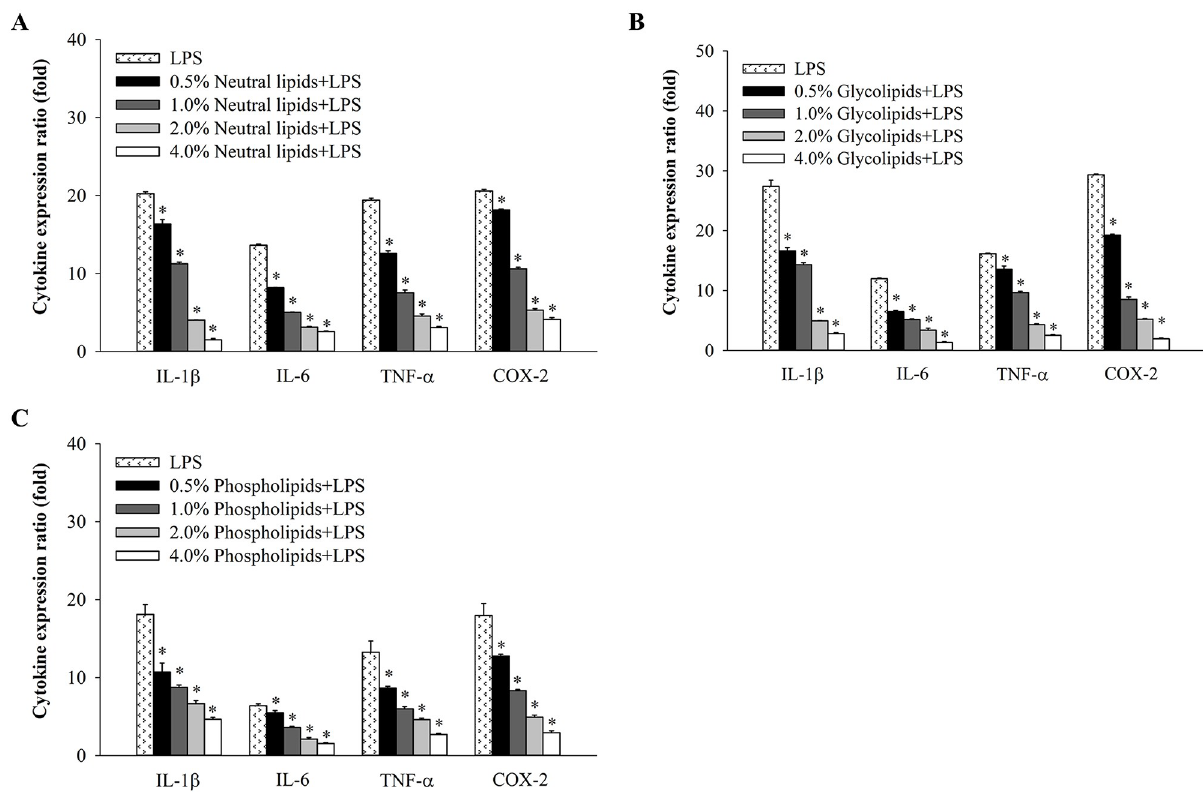
Fig 3. Quantification of immune-associated gene expression (fold) in LPS-stimulated RAW264.7 cells. (A) The relative mRNA expression of neutral lipids. (B) The relative mRNA expression of glycolipids. (C) The relative mRNA expression of phospholipids. Significant different at p < 0.05 ( � ) compared with